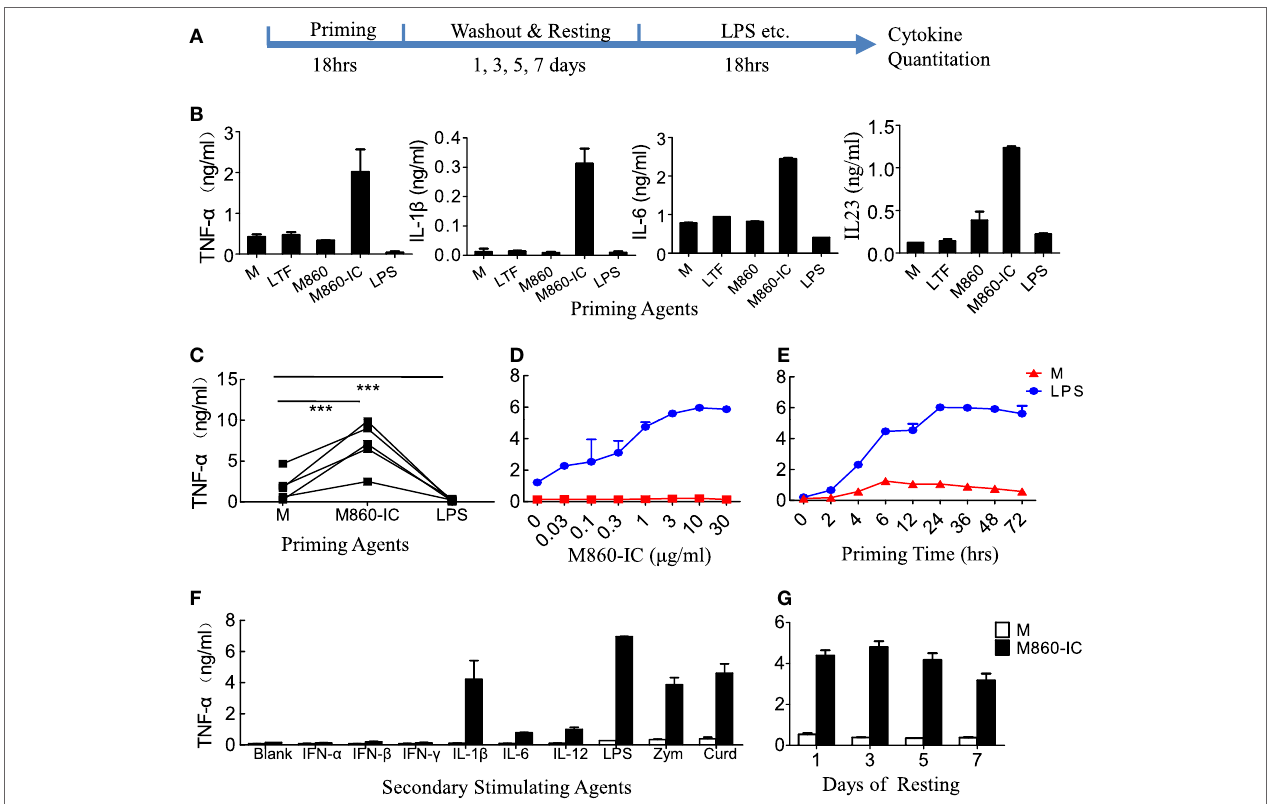
FigUre 4 | Hyper-responsiveness of M860-IC-treated M2 cells. (a) Diagram showing the course of the experiment examining hyper-responsiveness of the lactoferrin (LTF)-containing IgG immunocomplex (LTF-IC)-primed M2 cells. (b,c) (M-CSF)-M2 macrophages were primed for 18 h with, or without (M), 30 µg/ml human LTF (hLTF), M860, M860-IC, or 100 ng/ml lipopolysaccharide(LPS), followed by washout and resting and then a 24 h restimulation with suboptimal concentration (100 ng/ml) LPS. Cytokines in culture supernatants were quantitated using ELISAs. Data from different donors ( n = 5) are further compared in (c) , each pair of dots represents one donor. *** P < 0.001. (D) Dose curve and (e) time course of M860-IC priming of (M-CSF)-M2 macrophages. The results are expressed as TNF α secretion by the LTF-IC-primed M2 cells in response to a 18 h stimulation with, or without (M), 100 ng/ml LPS. (F) (M-CSF)-M2 macrophages pretreated with, or without (M), M860-IC were restimulated with a panel of stimuli, including LPS (100 ng/ml), zymosan (1 µg/ml), curdlan (1 µg/ml), IL-1 β (10 ng/ml), IFN- α / β (1,000 U/ml), IFN- γ (2,000 U/ml), IL-6 (100 ng/ml), or IL-12 (5 ng/ml), for 24 h. (g) (M-CSF)-M2 macrophages pretreated with, or without (M), M860-IC were allowed to rest 1, 3, 5 or 7 days in fresh medium, and then challenged with LPS (100 ng/ml) for TNF α production. The results, expressed as mean ±